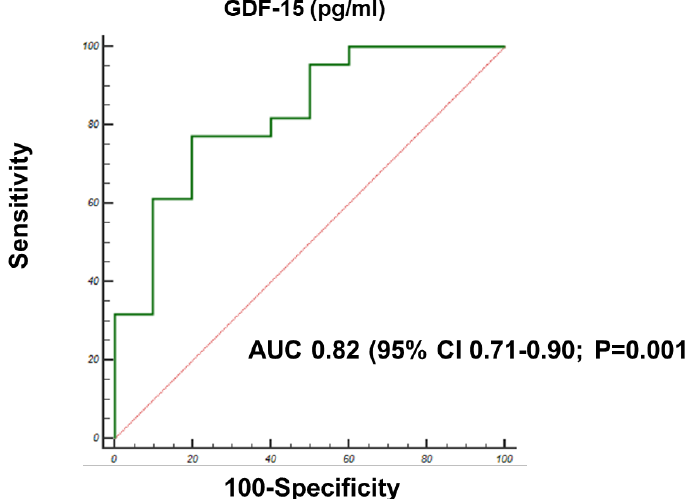
Figure 3. Receiver-operator curve and c-statistic analysis for the ability of GDF15 plasma levels > 2500 pg / mL to predict frailty (Katz score < 5). GDF15 levels > 2500 pg / mL had the highest AUC for discriminating more frail patients.